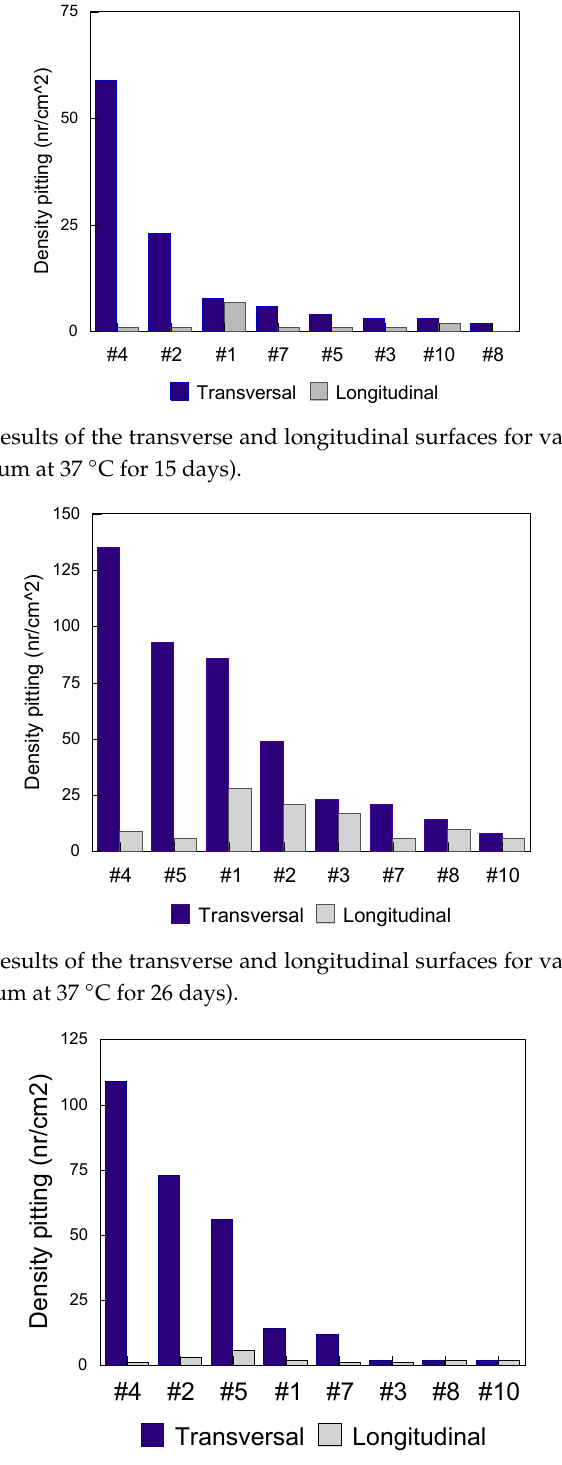
Figure 9. Pitting test results of the transverse and longitudinal surfaces for various grades of steels (artificial sweat test medium at 37 °C for 30 days).